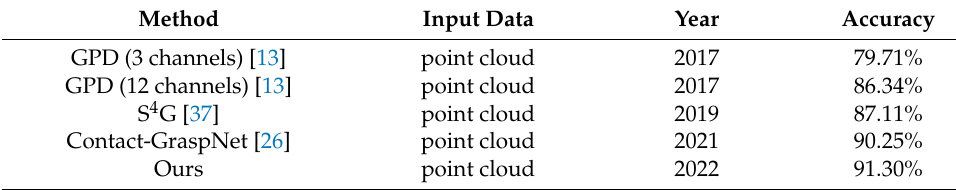
Table 4. Model training